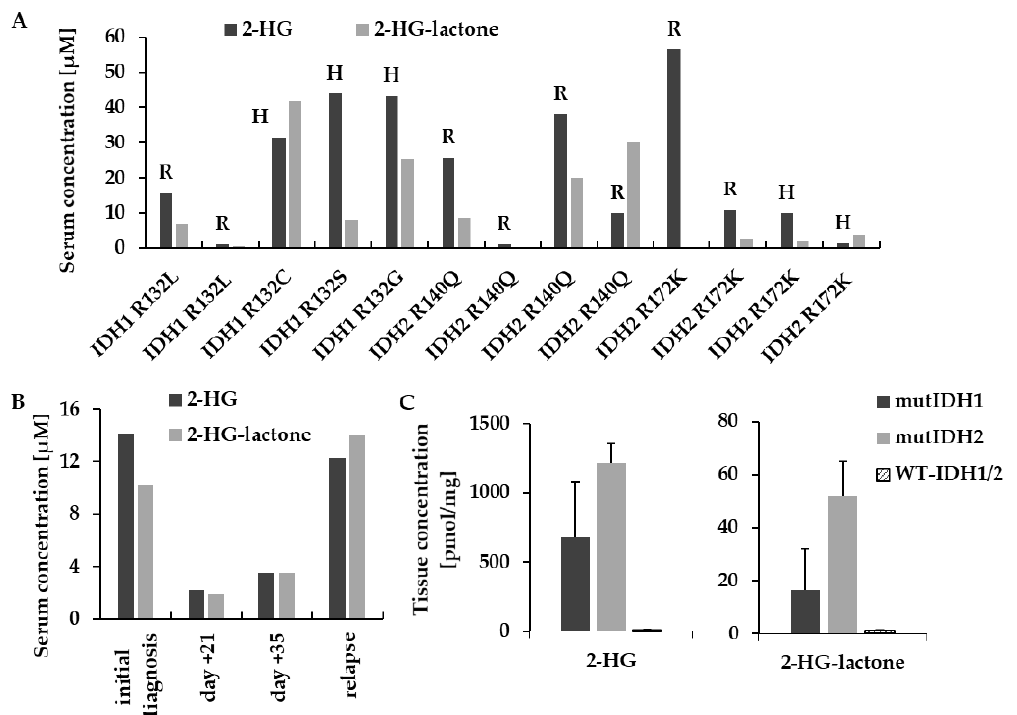
Figure 5. Analysis of 2-HG and 2-HG-lactone in biological specimens. ( A ) Serum samples from AML patients with different IDH1/2 mutations collected at two different sites (R = Regensburg; H = Hannover) that were drawn at different time points after diagnosis. ( B ) Exemplary time course of serum levels of 2-HG and 2-HG-lactone in an IDH2-R140Q -mutated AML patient. Initial response and subsequent treatment failure caused 2-HG and 2-HG-lactone serum levels to drop and rise in unison. ( C ) 2-HG and 2-HG-lactone levels in glioblastoma tissue samples (mut IDH1 : n = 6; mut IDH2 : n = 3; WT- IDH1/2 : n = 5; 2-HG: ANOVA p = 2.86 × 10 − 4 ; post-hoc test = Dunnett WT vs. mut IDH1 p = 2.12 × 10 − 3 ; WT vs. mut IDH2 p = 9.64 × 10 − 5 ; 2-HG-lactone ANOVA p = 1.25 × 10 − 3 ; WT vs. mut IDH1 p = 9.19 × 10 − 2 ; Wtvs. mut IDH2 p = 3.9 × 10 − 4 ).